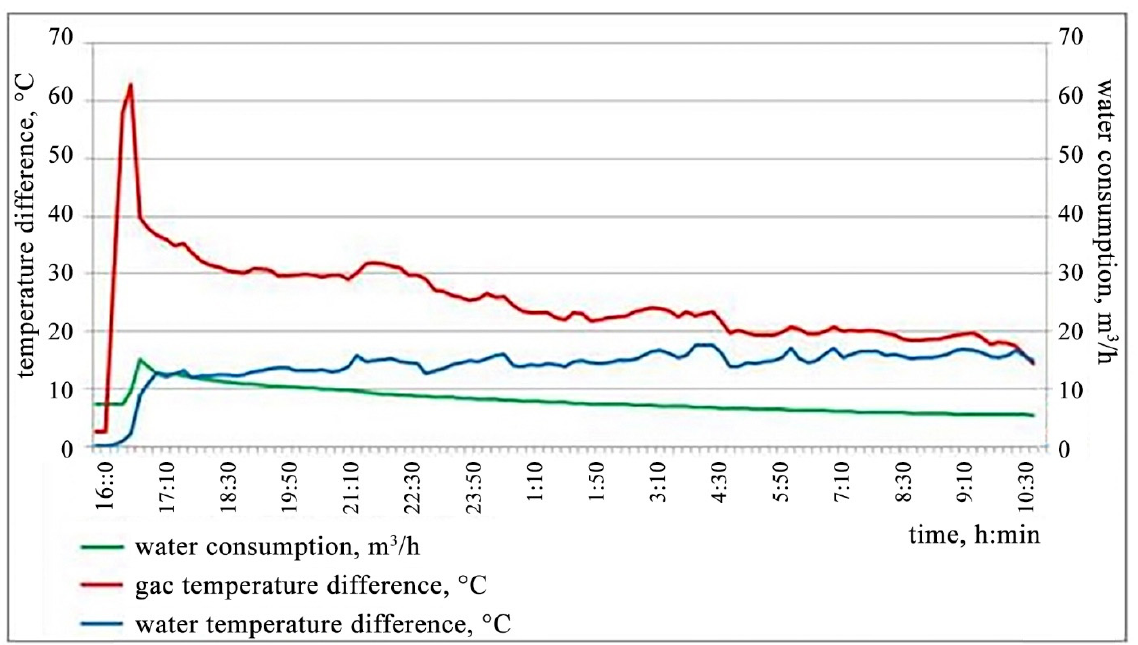
Figure 1. The results of the main parameters of the processes of cooling electrolysis gases using the experimental heat exchanger.